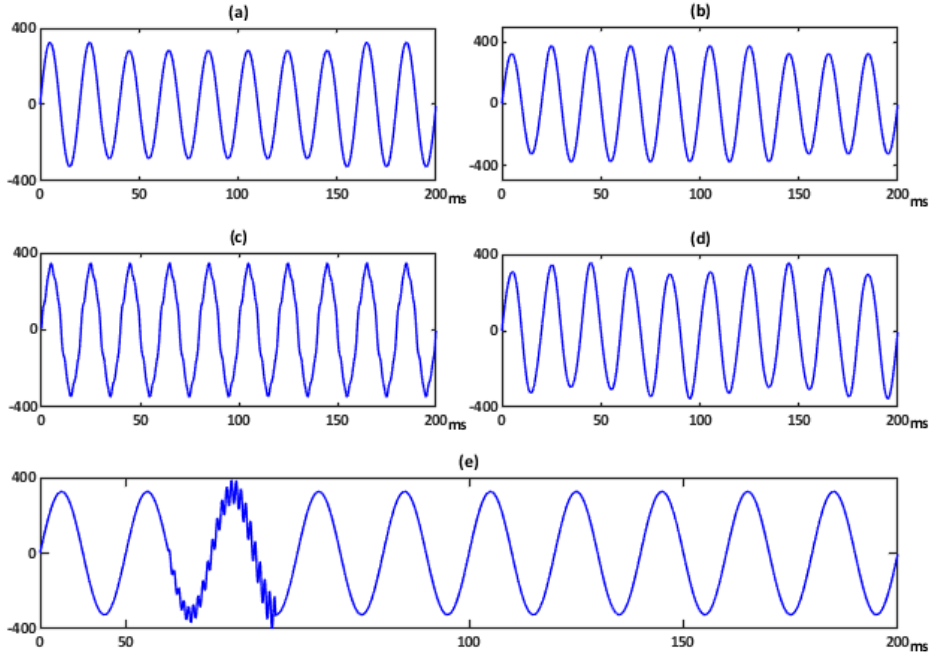
Figure 7. Single-phase voltage disturbances with similar THD. ( a ) Voltage sag1. ( b ) Voltage swell1. ( c ) Harmonic disturbances. ( d ) Flicker disturbance. ( e ) Transient1 disturbance.